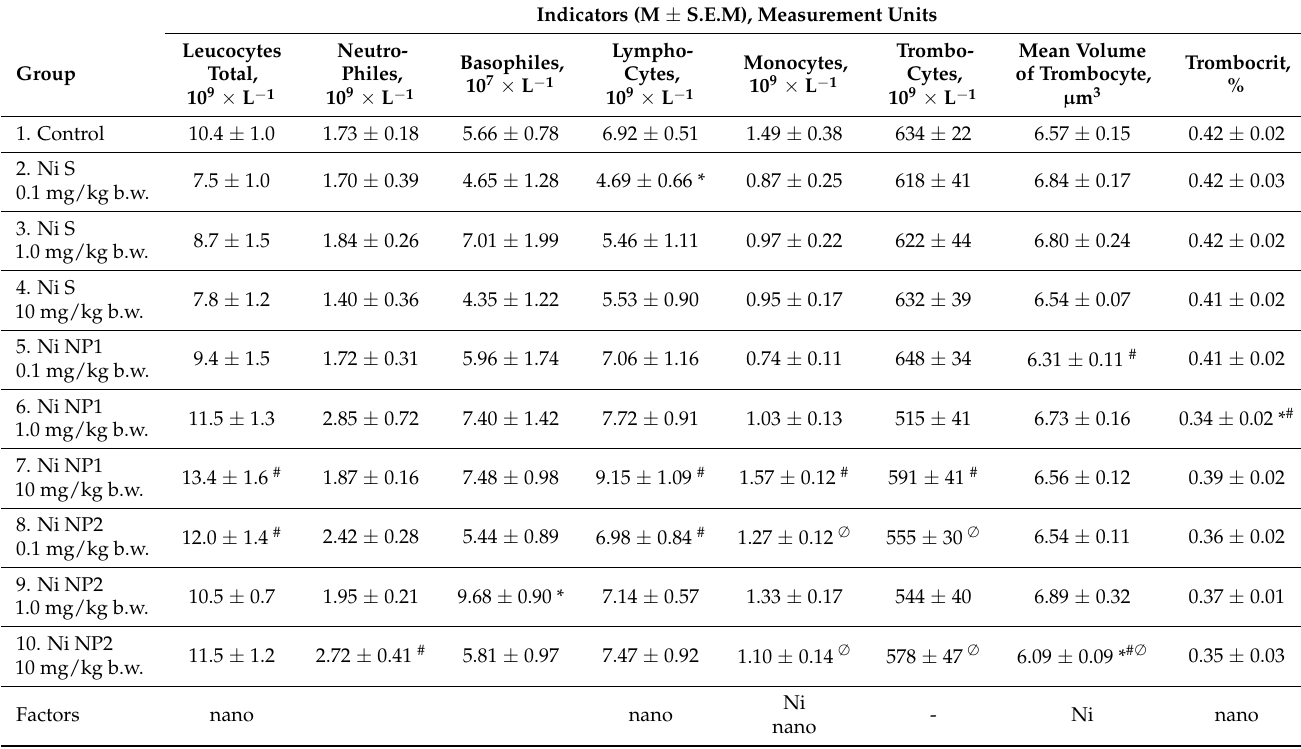
Table 3. Hematological indicators (leucocytes and thrombocyte counts) in